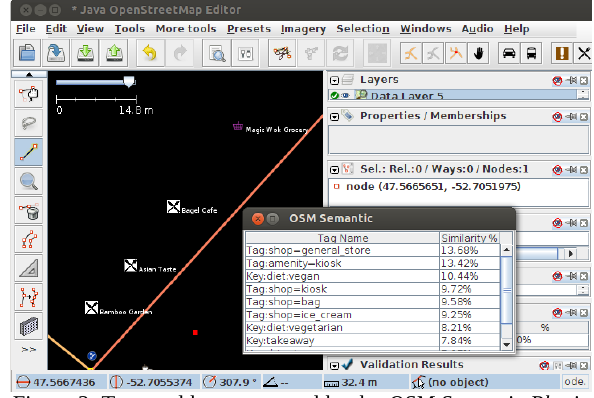
Figure 2. Tags and keys proposed by the OSM Semantic Plugin during the creation of a new object (i.e., red point) All similar tags and their similarity score are displayed in a